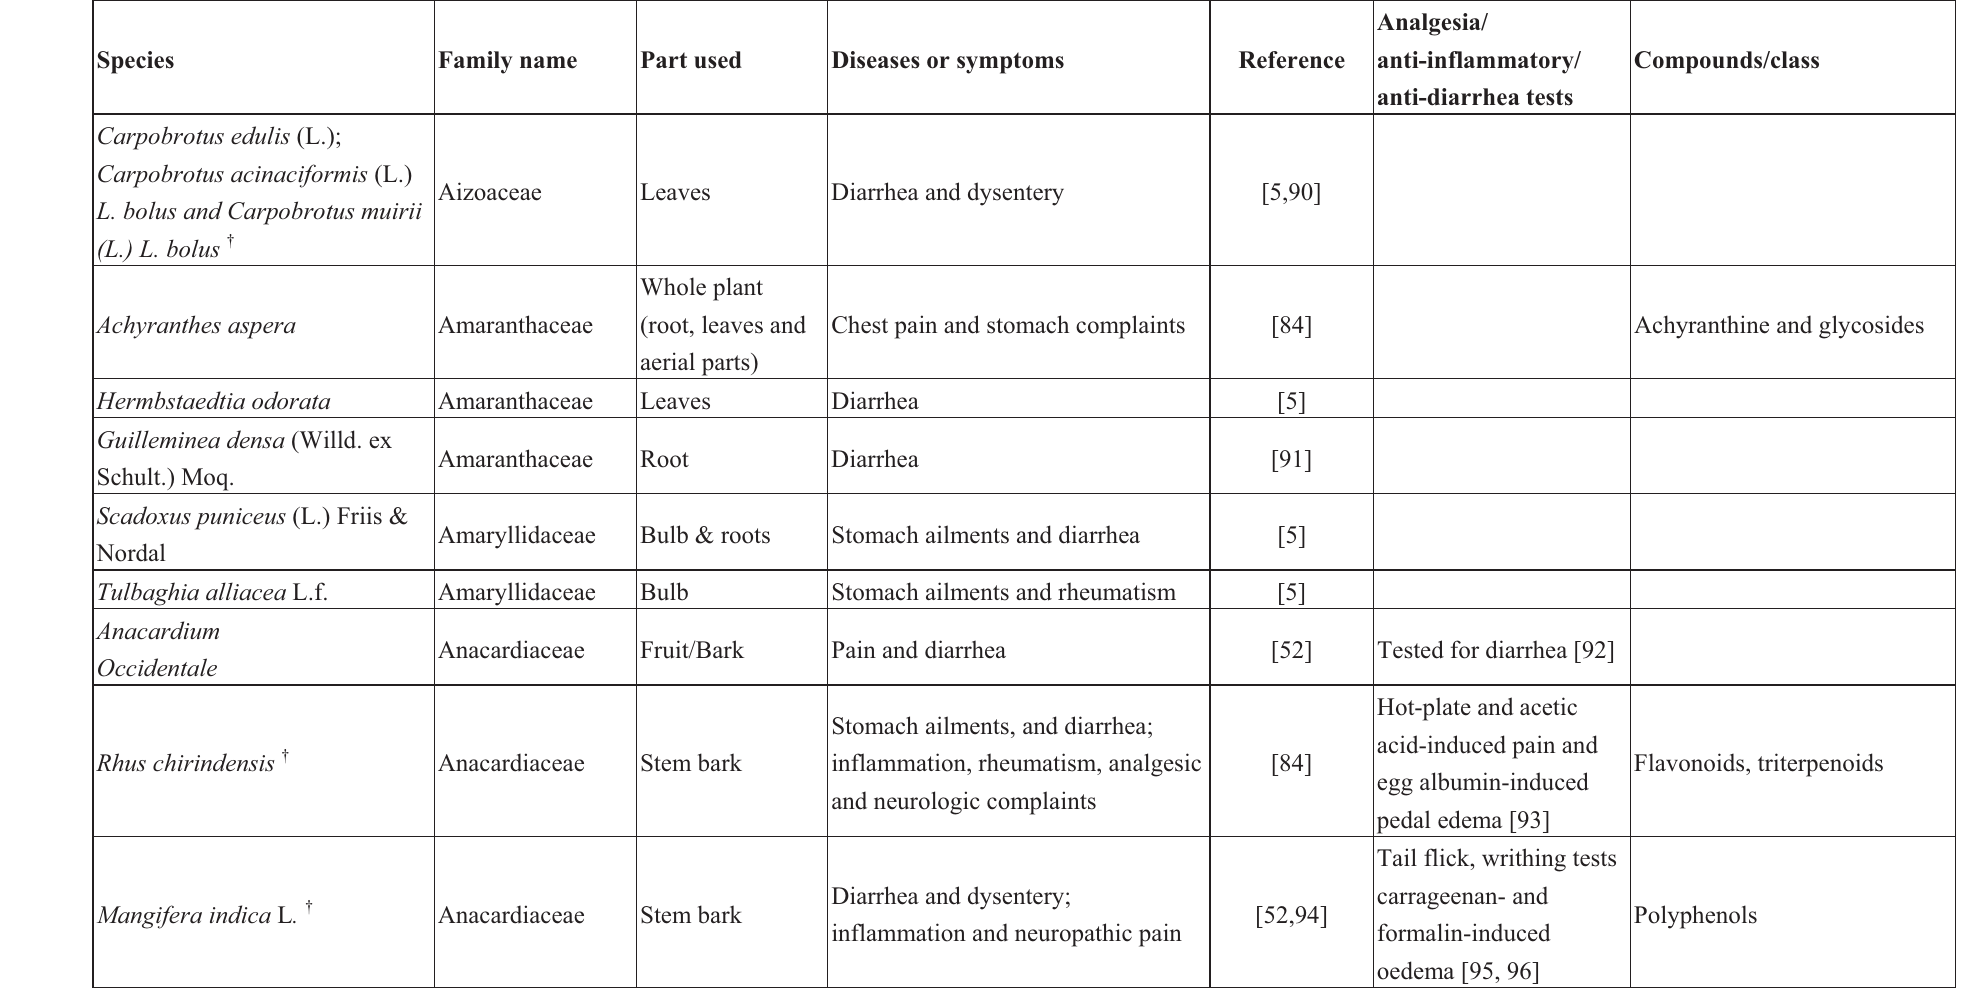
Table 2. An inventory of African herbal therapies against human gastrointestinal pain and